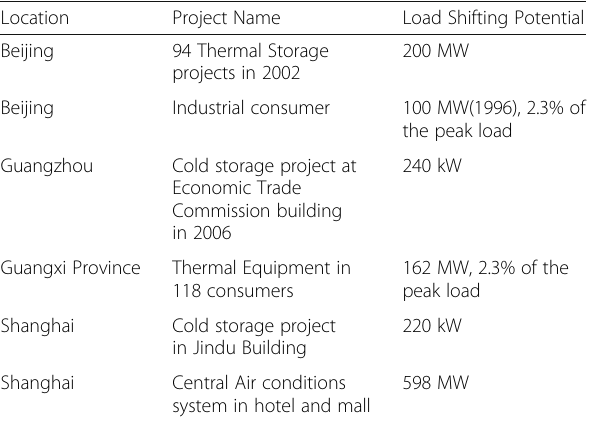
Table 1 Load shifting potential analysis of thermal storage in